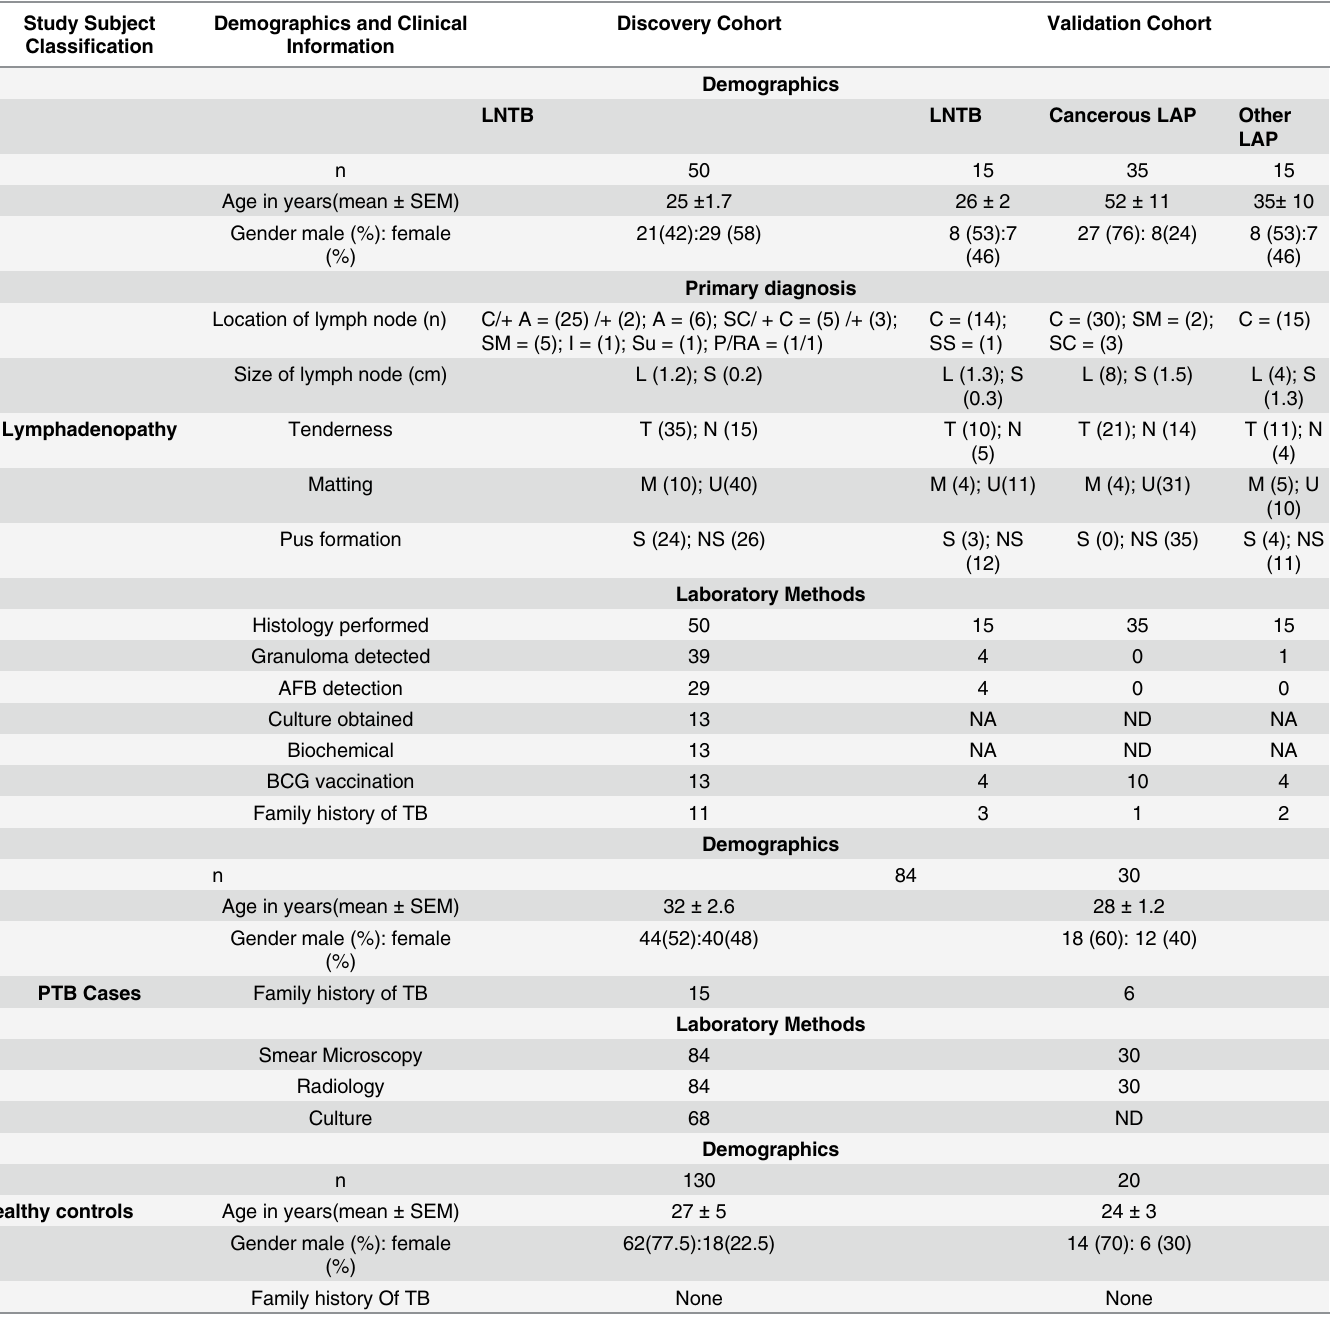
Table 1. Showing Demographical and Clinical Characteristics of the Study